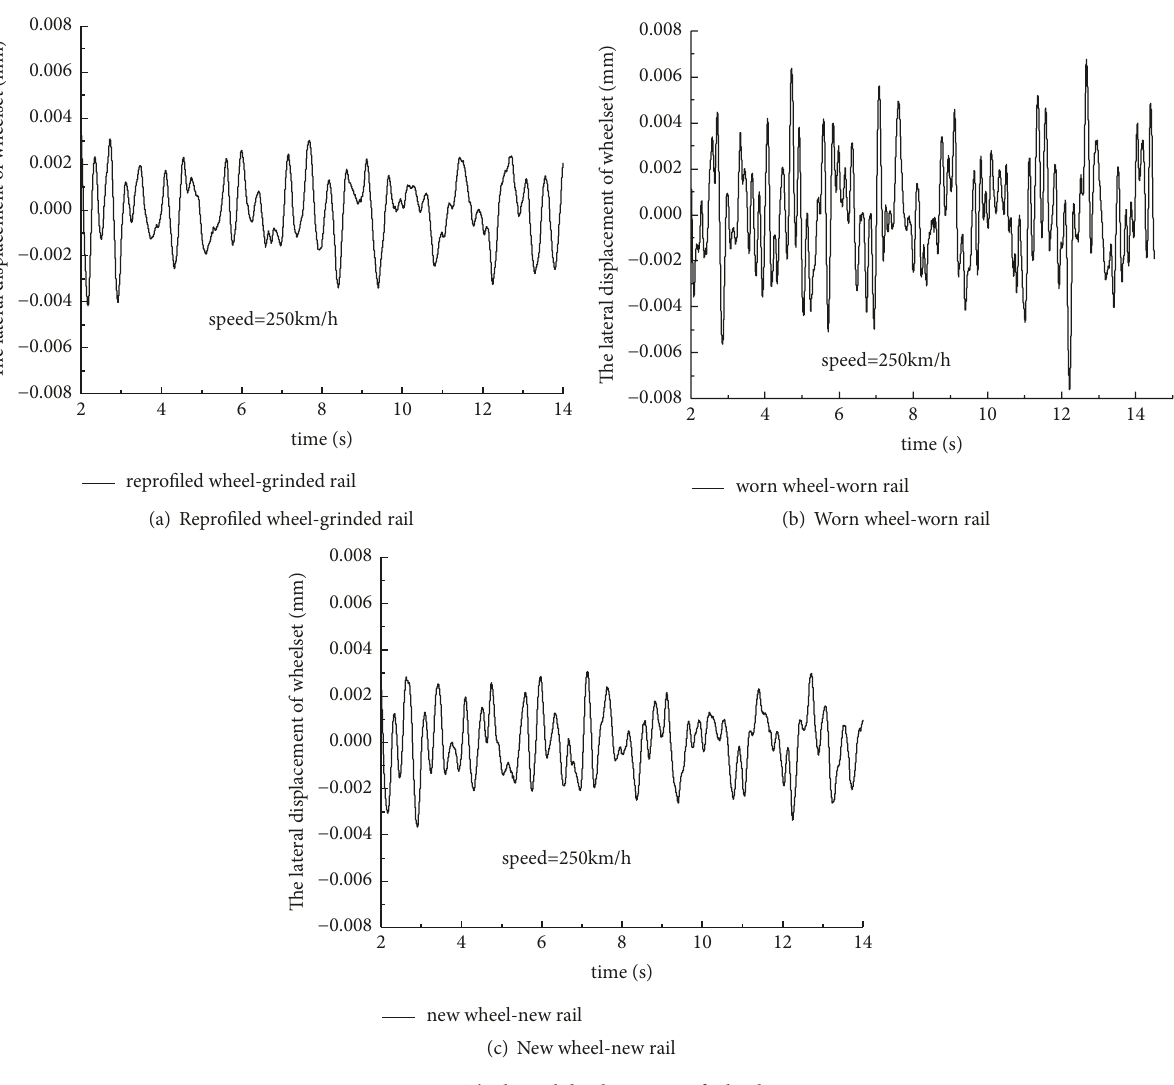
Figure 15: The lateral displacement of wheel